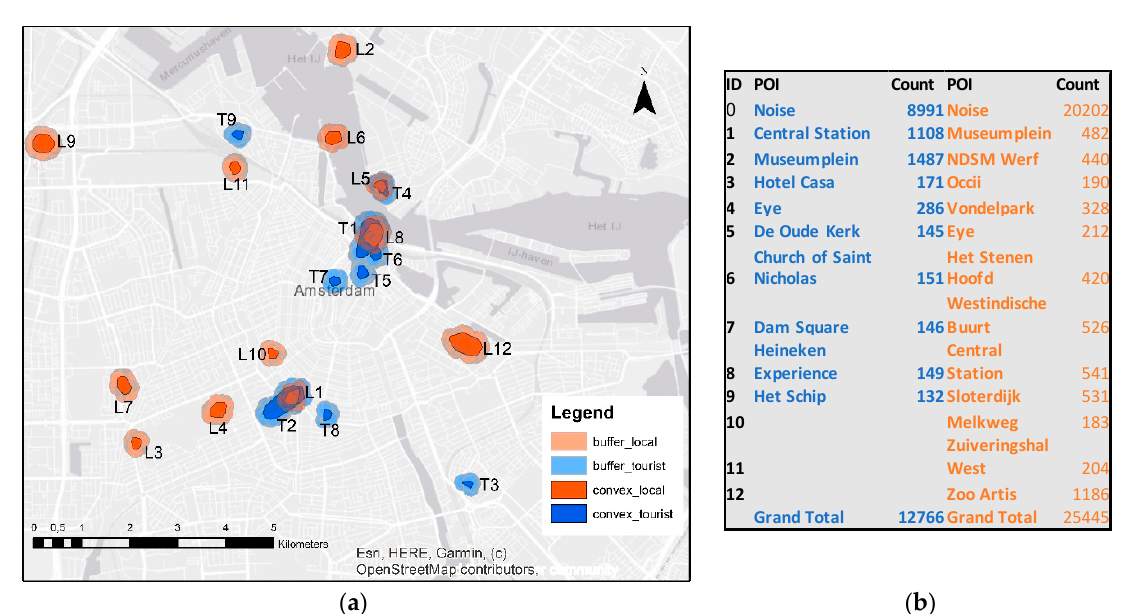
Figure 3. Distribution of clusters (points of interest (POIs)) for tourist and local: ( a ) map; ( b ) counts of photos per POI.